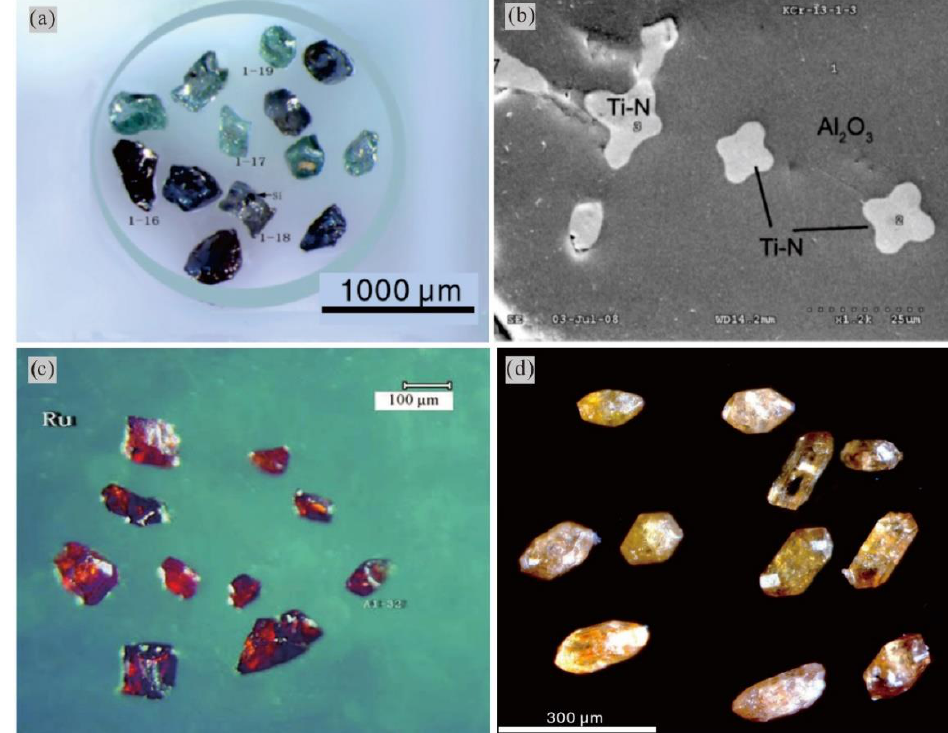
Figure 5. Mantle- and crust-derived minerals associated with diamond in ophiolitic chromitite and peridotite. ( a ) Moissanites from the Dingqing chromitite [27]; ( b ) Corundum and its inclusions from the Kangjinla chromitite [115]; ( c ) Rutiles from the Dangqiong harzburgite [23]; ( d ) zircons from the Dingqing chromitite [27].